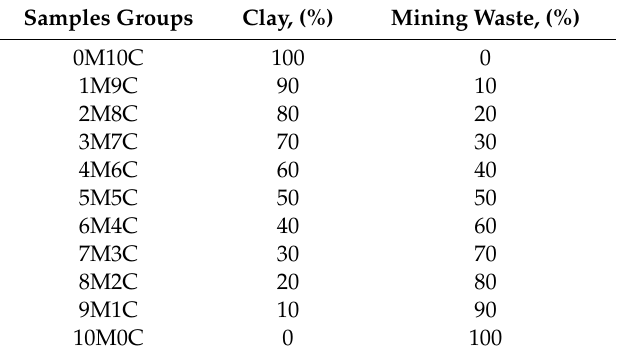
Table 1. Conformed ceramics families with combined percentages of clay and mining waste. Samples Groups Clay, (%) Mining Waste, (%) 0M10C 100 0 1M9C 90